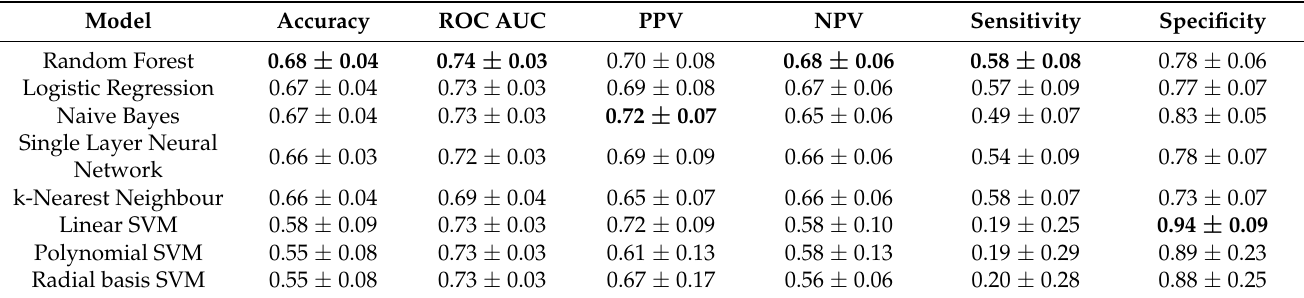
Table 3. Summary of machine learning algorithms predictive performances (mean ± standard deviation, bold entries are maximum